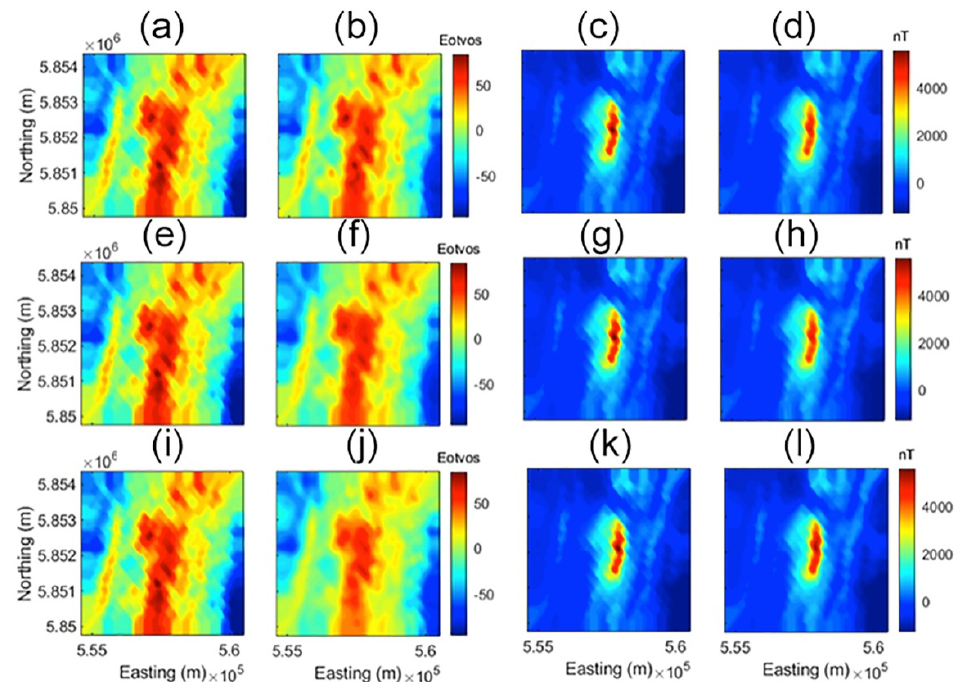
Figure 8. Case study. Panels ( a , b ) show observed and predicted Gzz gravity gradient data inverted standalone, respectively. Panels ( c , d ) show observed and predicted TMI data inverted standalone, respectively. Panels ( e , f ) show observed and predicted Gzz gravity gradient data inverted jointly with Gramian constraints, respectively. Panels ( g , h ) show observed and predicted TMI data inverted jointly with Gramian constraints, respectively. Panels ( i , j ) show observed and predicted Gzz gravity gradient data inverted with joint focusing, respectively. Panels ( k , l ) show observed and predicted TMI data inverted with joint focusing, respectively.